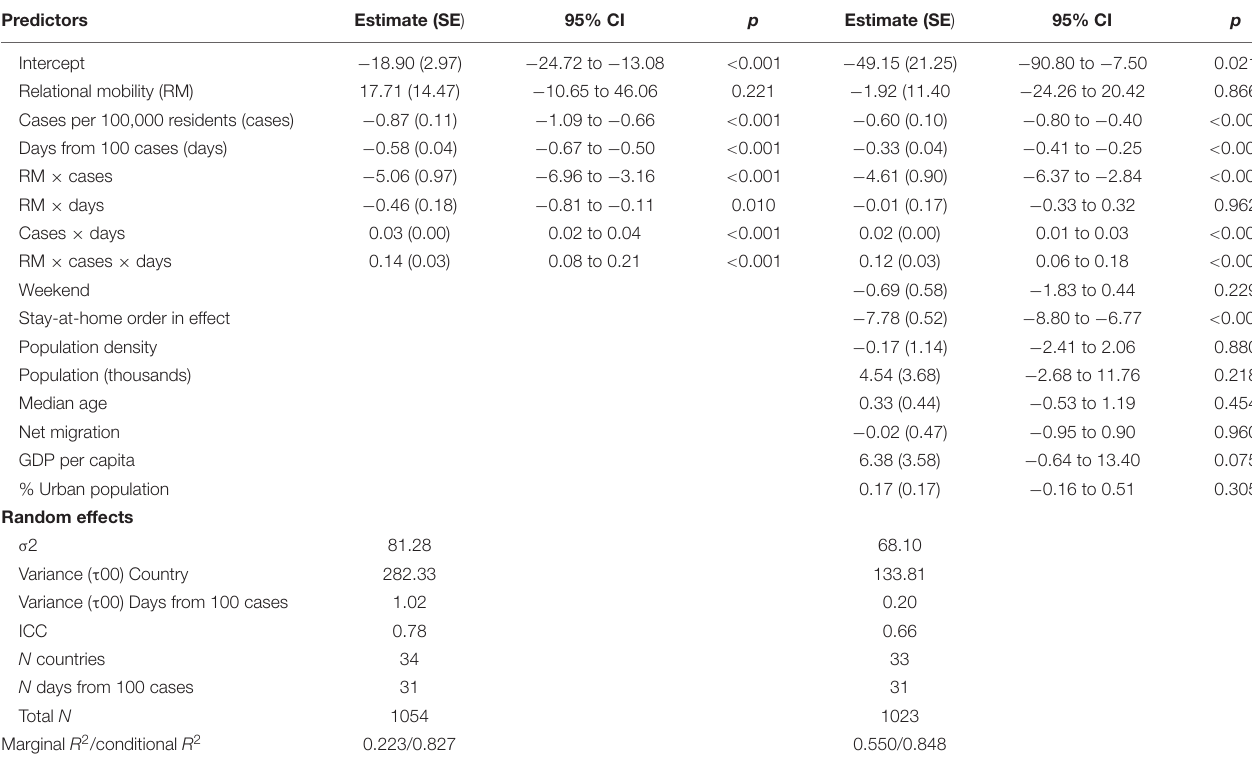
TABLE 5 | The impact of relational mobility and cases per 100,000 residents on change in geographic mobility following the first 100 cases of COVID-19 in each country.